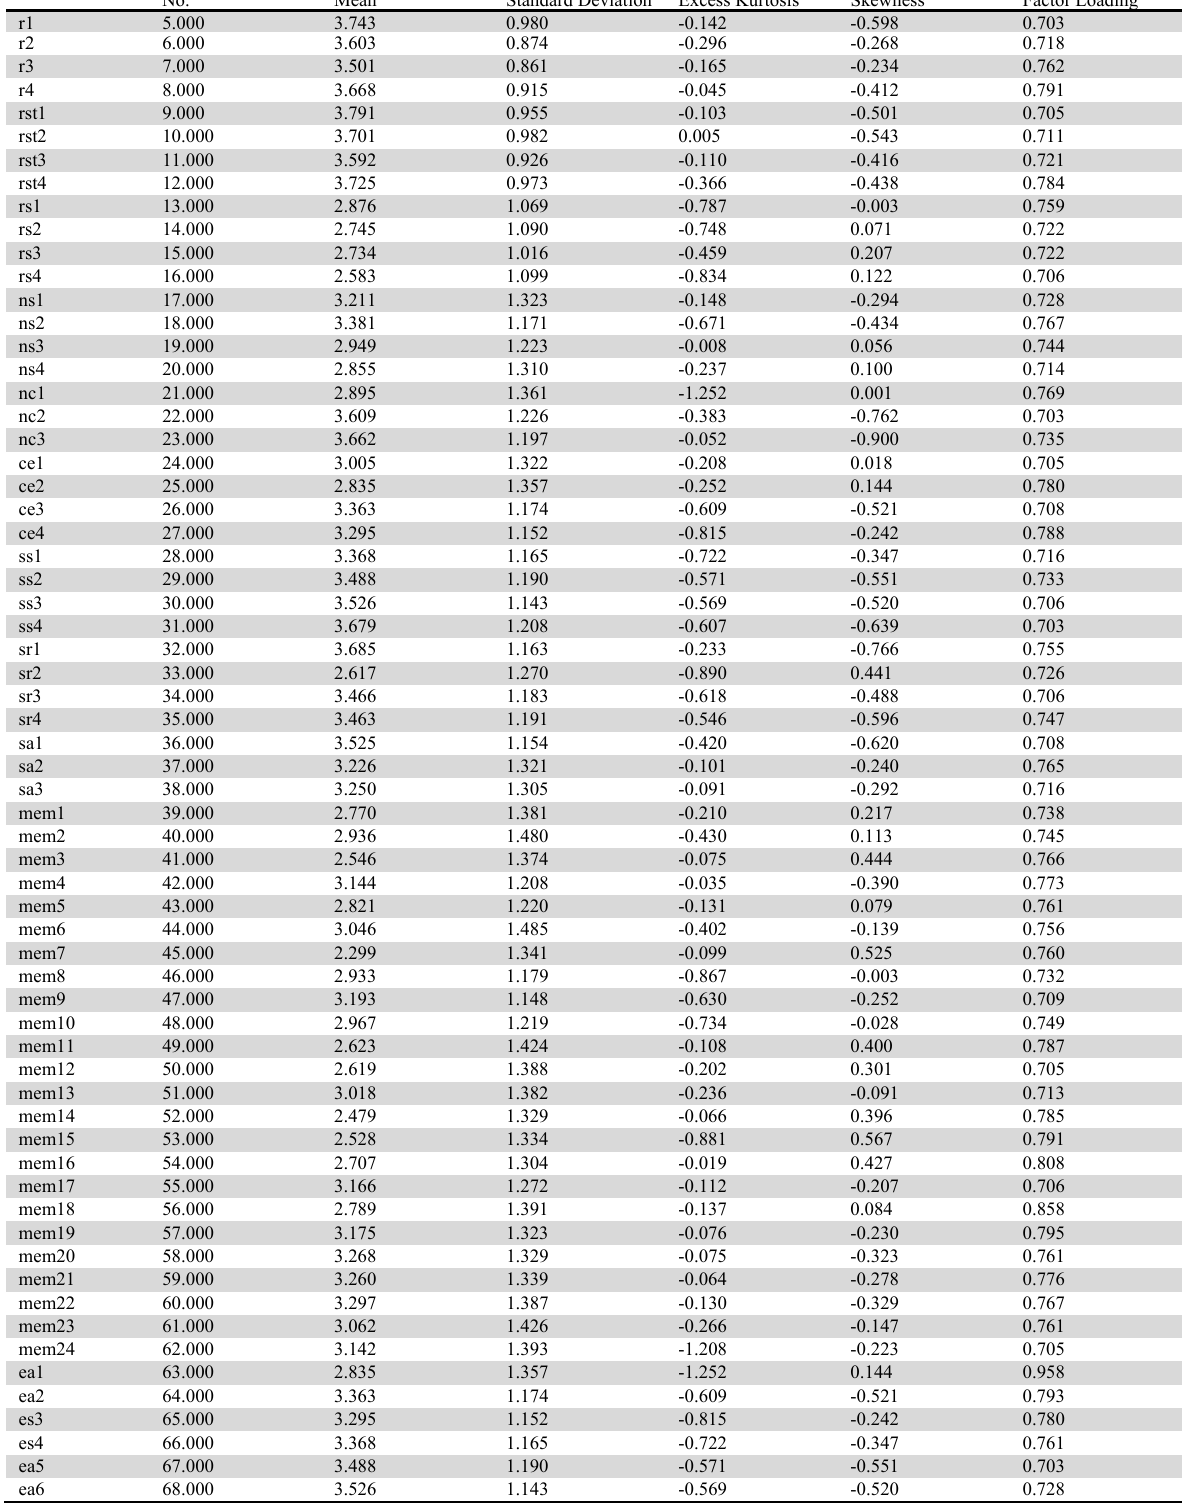
Table 5 Means, standard deviation, kurtosis, skewness, and